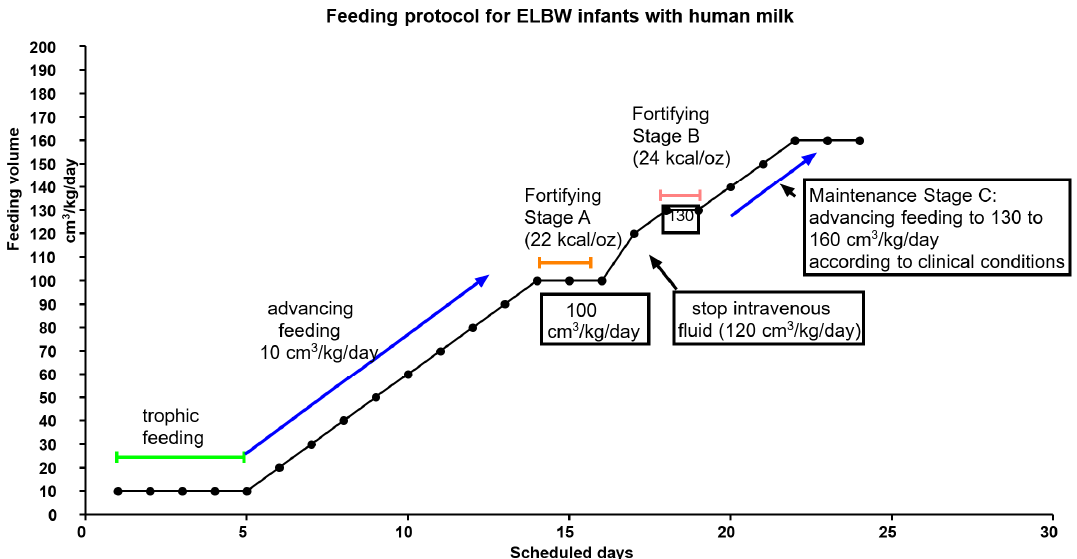
Figure 1. The scheduled feeding protocol for the extremely low birth weight infants.